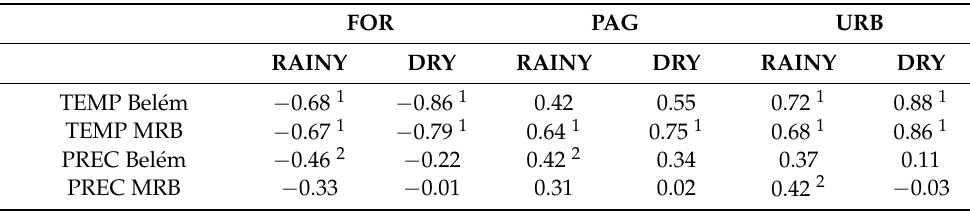
Table 1. Pearson’s correlations between the landcover class areas and the TEMP and PREC in the RAINY and DRY regimes. Time series in the period 1985–2020.